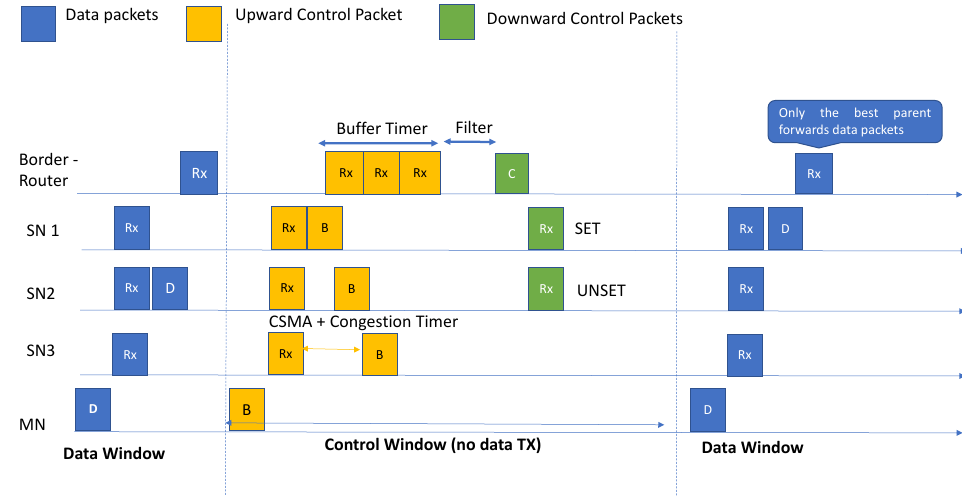
Figure 3. Time diagram of handoff process in SDMob showing how buffer timer and congestion timer and SET/UNSET commands improve the basic SDMob